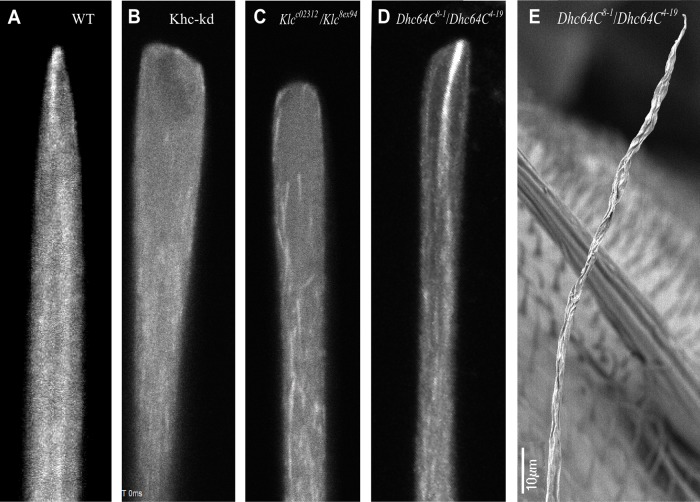
GFP-EB1 fails to concentrate as foci at the bristle tip in Khc-kd and Klc mutants. (A-D) Confocal projections of bristles from wild type (A), Khc-RNAi; neur-Gal4 (B) and Klcc02312/Klc8ex94 (C) and Dhc64C8-10/Dhc64C4-19 (D) mutants expressing GFP-EB1. (E) Scanning electron micrographs of upper part of bristle from Dhc64C8-10/Dhc64C4-19 mutants. GFP-EB1 concentrates as foci at the tip of the bristle both in wild type and in Dhc64C8-10/Dhc64C4-19 but not in Khc and Klc mutants. Dhc64C mutants bristle tip is thin and twisted.